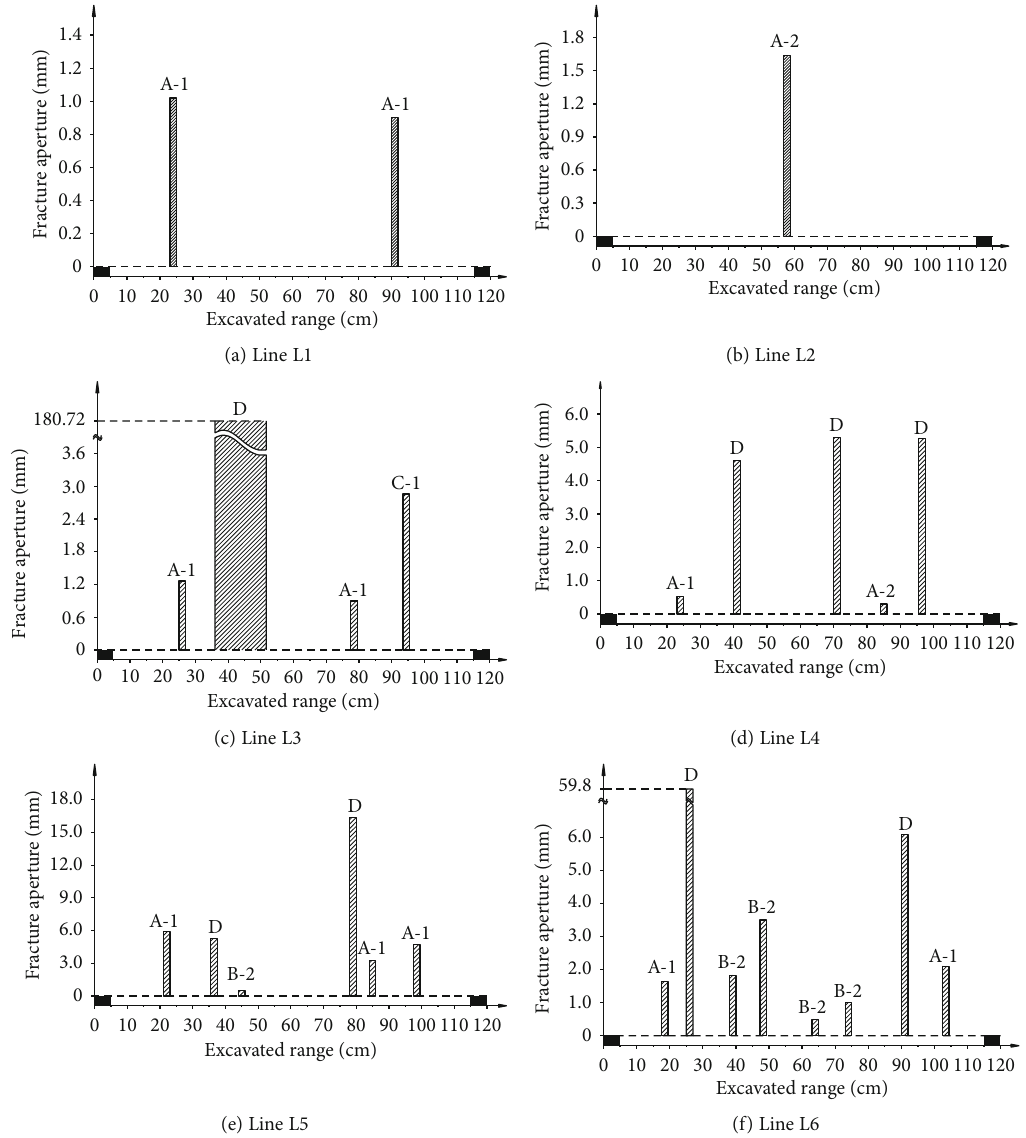
Figure 6: Distribution of the types and apertures of the mining-induced fractures at di ff erent